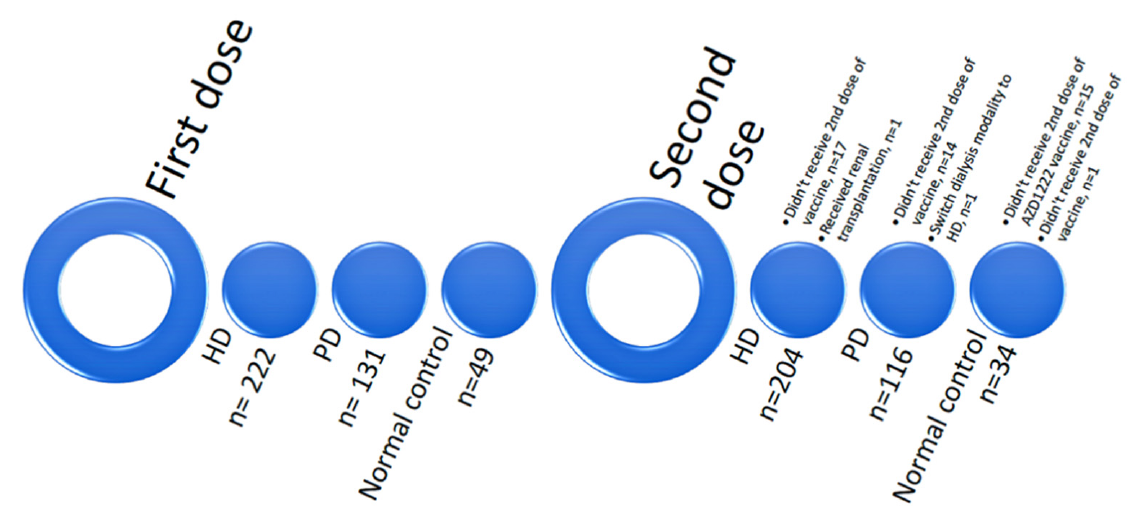
Figure 1. Study population.